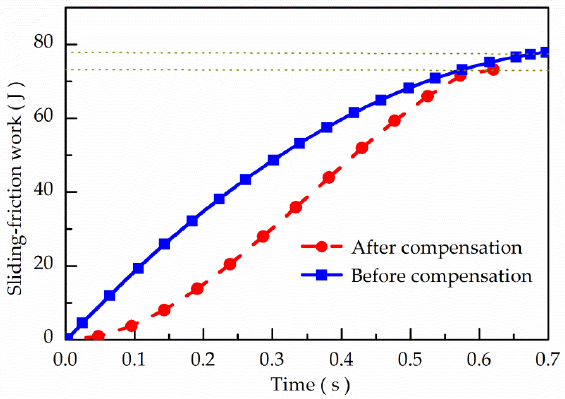
Figure 11. Comparison of sliding-friction work before and after compensation.